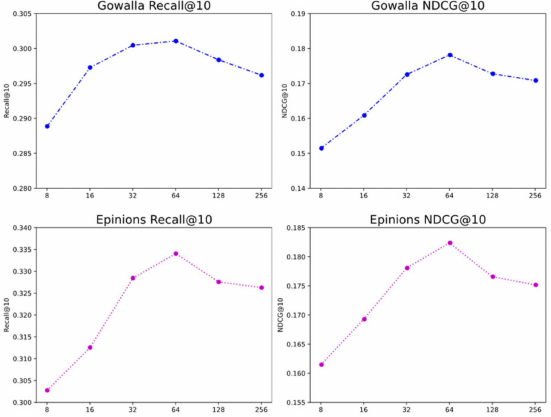
Figure 8. Effect of embedding size d on Gowalla and